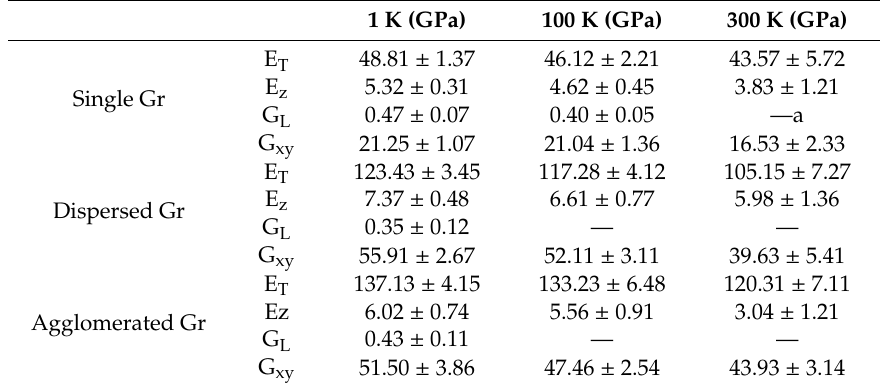
Table 4. The calculated Young’s and shear modulus of nanocomposite with three di ff erent morphology at di ff erent